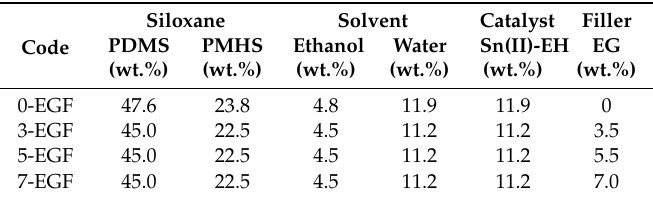
Table 1. Composite graphite-based foams